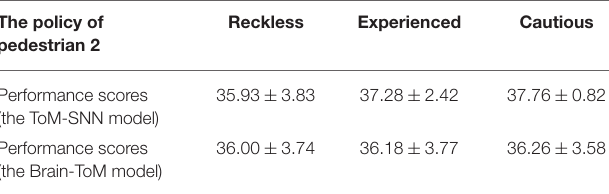
TABLE 4 | Compared bystander’s performance